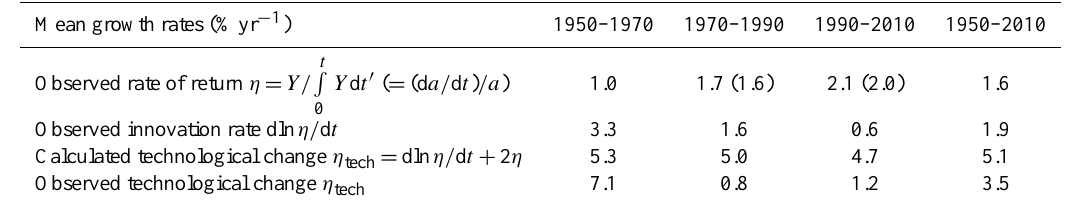
Table 3. Twenty- and 60-year averages of rates of return (calculated using two independent techniques), innovation rates, and rates of technological change. Values are derived from Eqs. (11) and (12) and using data from Table